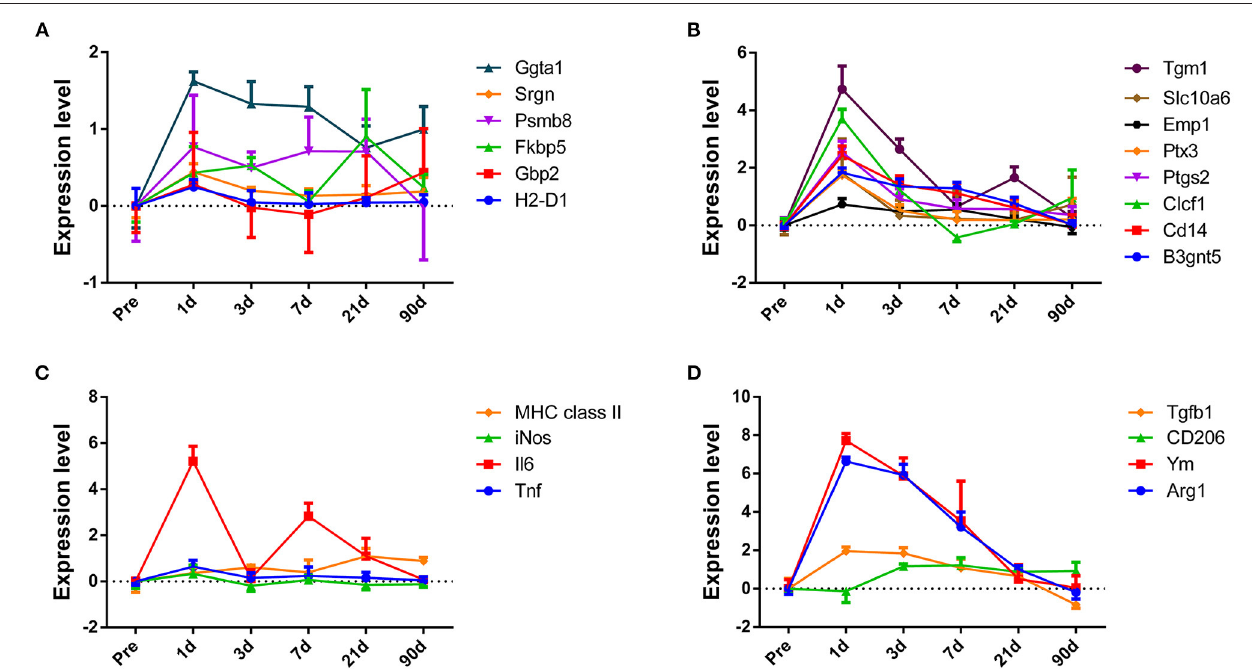
FIGURE 7 | The changes in expression levels of subpopulations of astrocyte and microglial marker genes after crush injury. Overall, there was an obvious expression pattern difference between the subpopulation of astrocyte and microglial markers. (A,B) Genes expressed by A1- and A2-reactive astrocytes. (C,D) Genes expressed by M1 and M2 microglia,